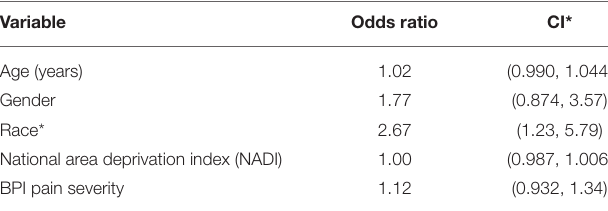
TABLE 2 | Sociodemographic and SES predictors of use of one or more pharmacologic therapies ( n = 174).